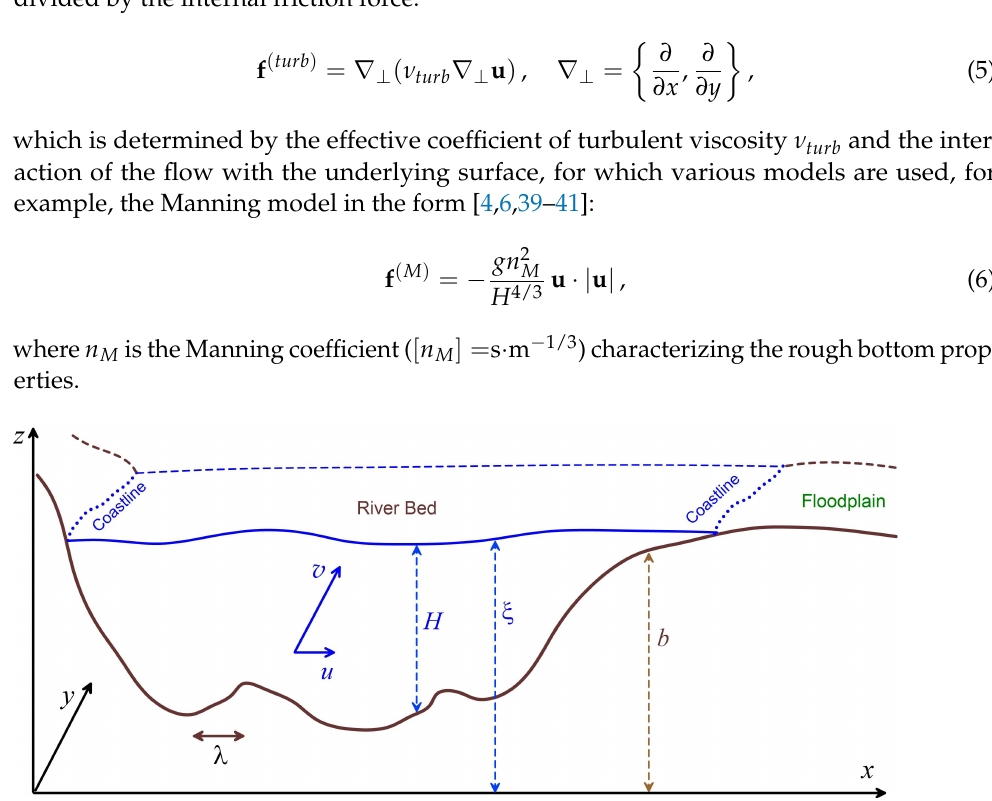
Figure 7. Geometric scheme of a single-layer model of shallow water. The main river channel is directed along the y -coordinate. The terrain height b ( x , y ) depends on coordinates and does not depend on time. The water level is ξ = b + H ( H is the depth of the